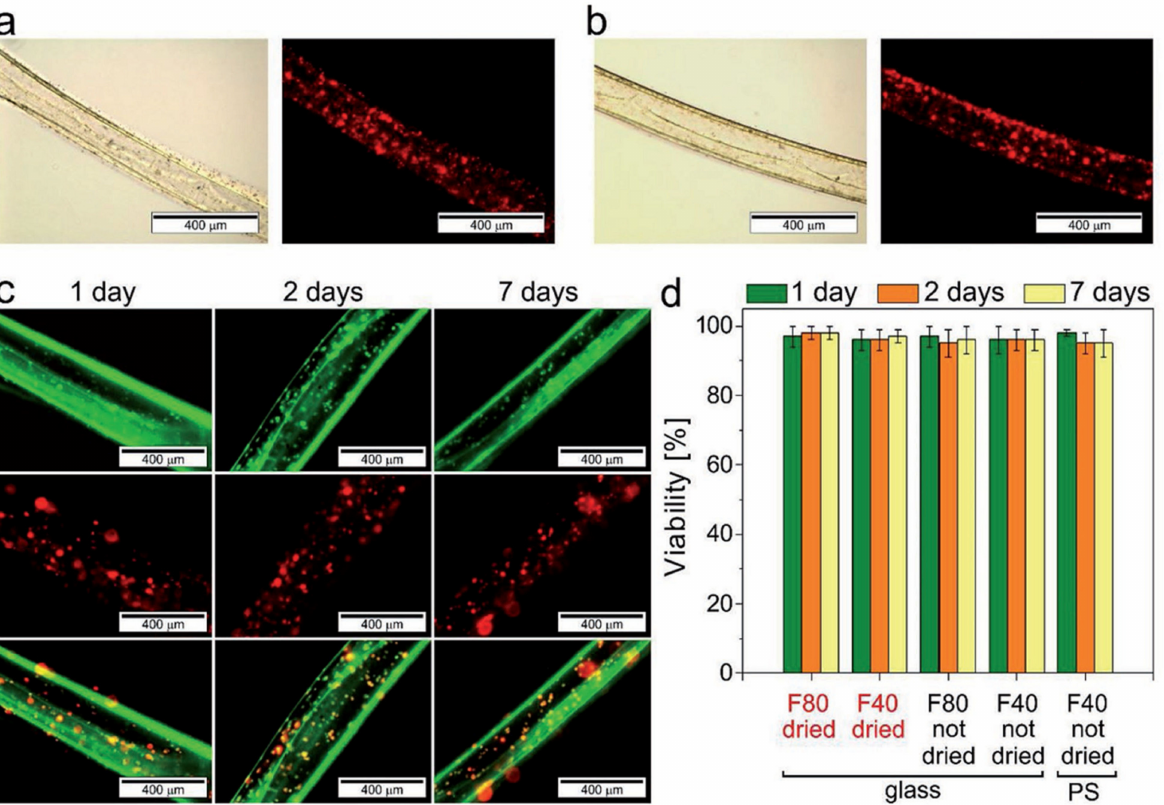
Figure 5. Four-dimensional fabricated cell-laden hydrogels. ( a , b ) Representative light (left) and fluorescence (right) microscopy images of self-folded AA-MA tubes; ( c ) fluorescent images of AA-MA tubes during different days; ( d ) cell viability assessment inside tubes during different days. The two types of samples (marked red) displayed good tube formation, and the other three samples (controls), which were printed without drying while crosslinking process, were provided as controls. Copyright 2017 Advanced Materials. Reprinted with permission from ref.